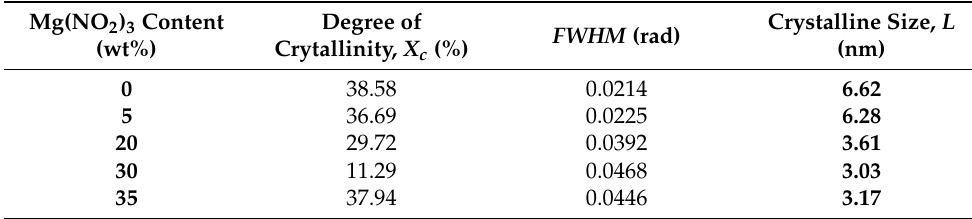
Table 1. The degree of crystallinity, X c and size of crystallite, L of selected agarose–Mg(NO 3 ) 2 polymer electrolyte samples.